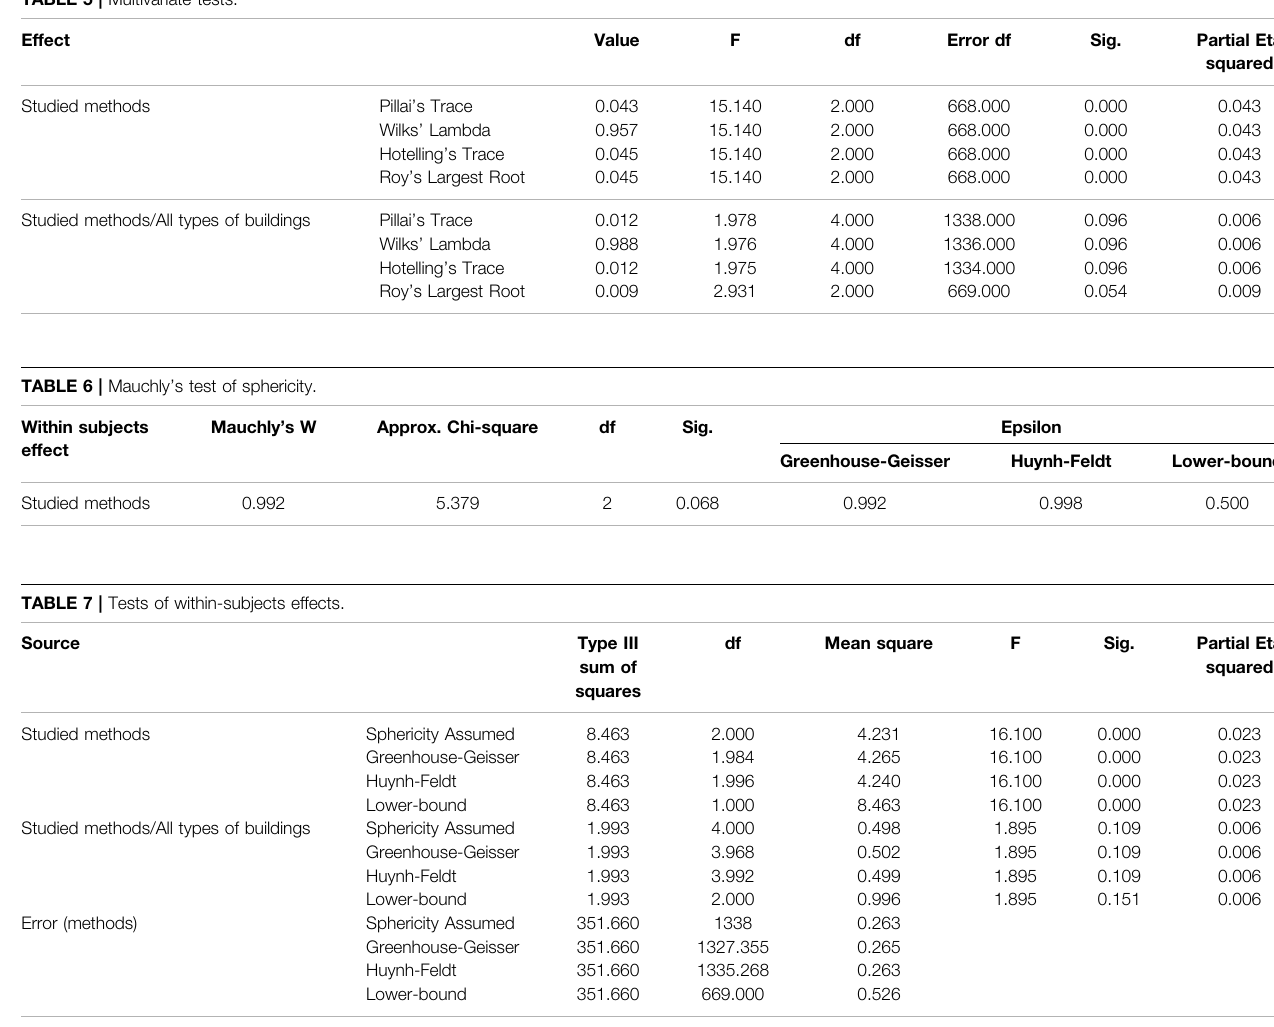
TABLE 5 | Multivariate tests.